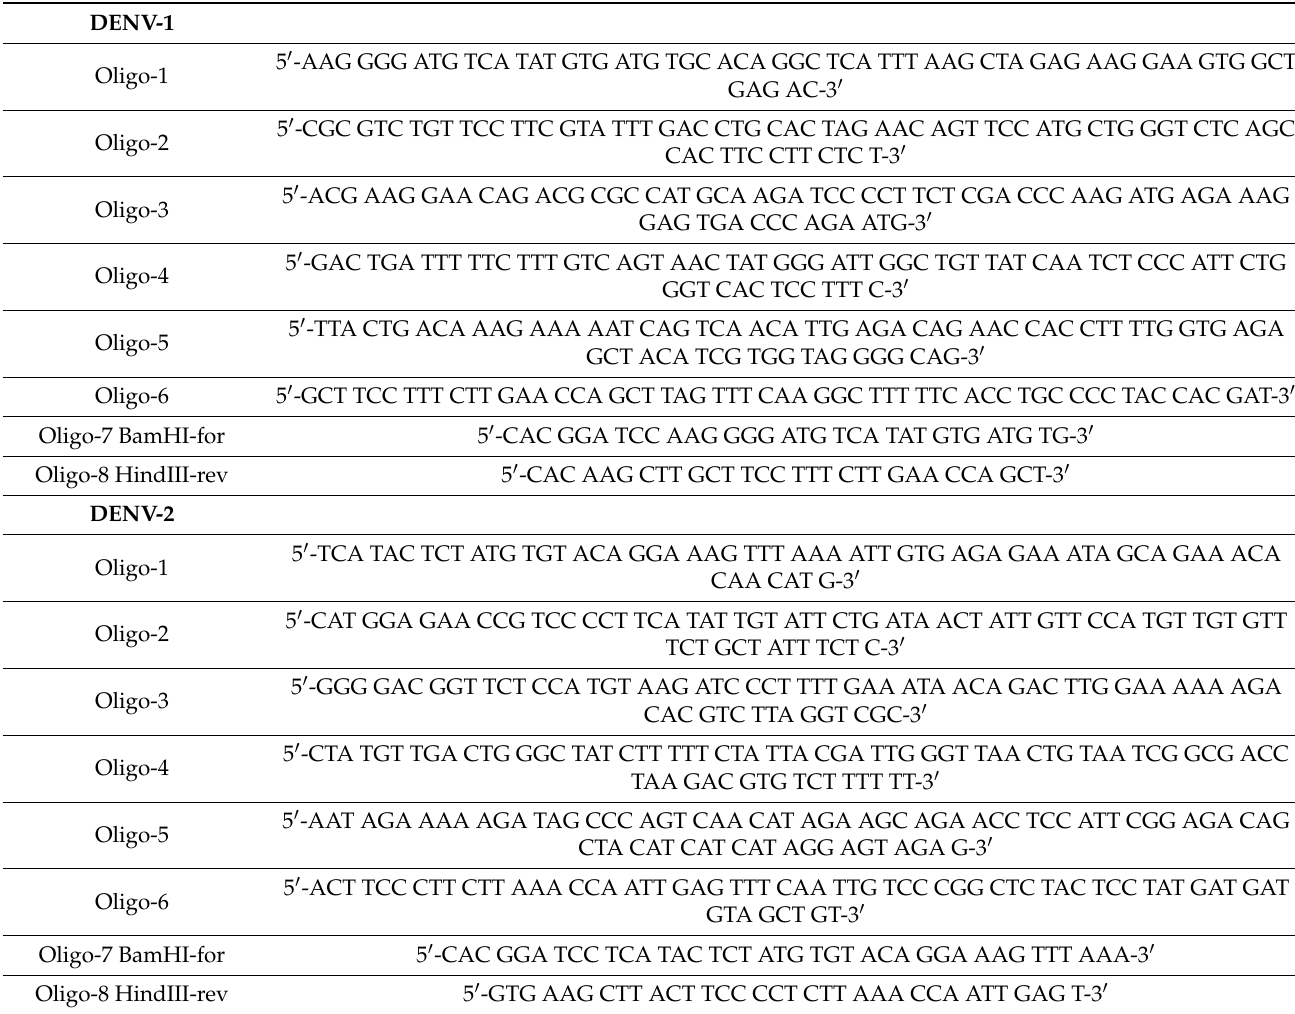
Table A1. Oligonucleotides for the cloning of COL MBP–ED3 fusion